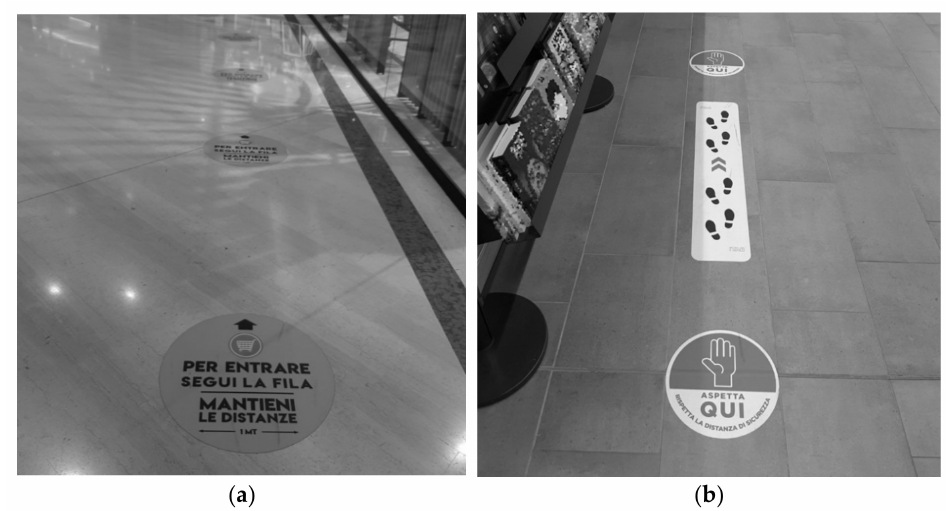
Figure A5. Images illustrating examples of horizontal signage (F) suggesting to users the route to follow while reminding them to keep the social distance in queues ( a , b ).